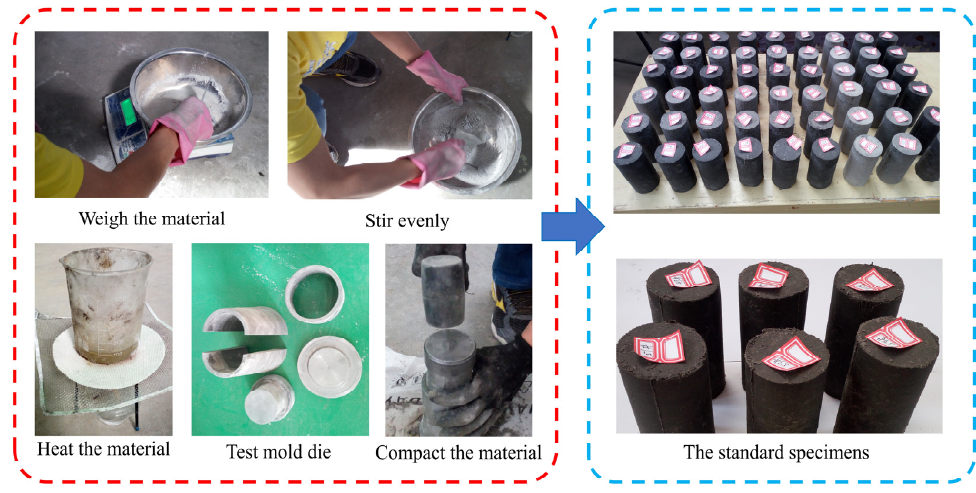
Figure 2. Similar material specimens ‐ making process.